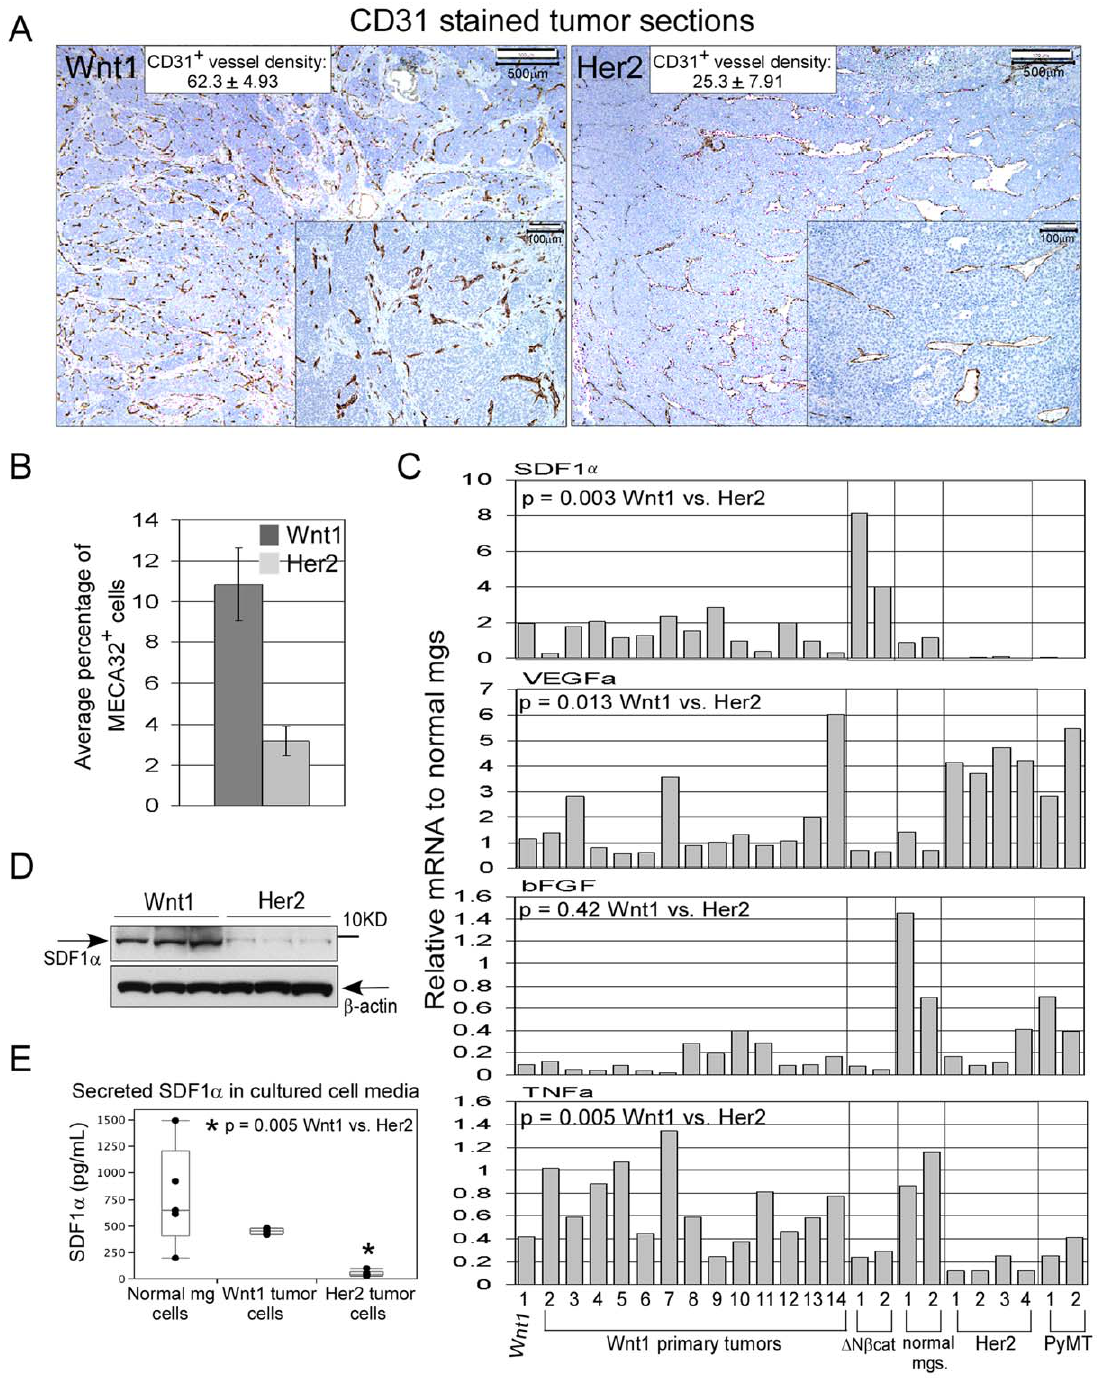
Figure 1. Analysis of Wnt1 tumor vasculature and potential factors that contribute to tumor vasculature. A, immunohistochemical stained Wnt1 and Her2 tumor sections with anti-CD31 antibody (brown) and hematoxylin (blue). The inserts are zoomed in regions of the tumor sections, which were used to score for micro-vessel density. Average numbers of CD31 + vessels per 0.45 mm 2 are shown for each tumor types, and averages were derived from scoring three random sections per tumor, and n=3 tumors for Wnt1 and Her2. + / 2 values represent standard deviations. B, quantitation of MECA32 + cells in tumors by FACS analysis. Average percentage of MECA32 + cells was derived from analysis of five independent Wnt1 (dark bar) and Her2 tumors (light bar), and error bars represent + / 2 SEM. C, qRT-PCR analysis of indicated mRNA transcript levels in various MMTV tumors and normal mammary glands. Primary Wnt1 tumors are as indicated, and all of the other tumors are from passaged tumors. All reactions were performed in duplicates and relative mRNA level for each gene was calculated by normalizing to average transcript levels of normal mammary glands. D, immunoblot analysis of SDF1 protein immunoprecipitated from lysates of Wnt1 and Her2 tumors, and aliquots of input tumor lysates for immunoprecipitation were blotted for b -actin. E, ELISA analysis of secreted SDF1 a protein in media taken from cultured normal mammary gland cells, Wnt1 tumor cells, and Her2 tumor cells. Media were collected from five individually plated tumor or normal mammary cells, and * indicates that lower amount of secreted SDF1 a in the Her2 cell media is statistically significant.